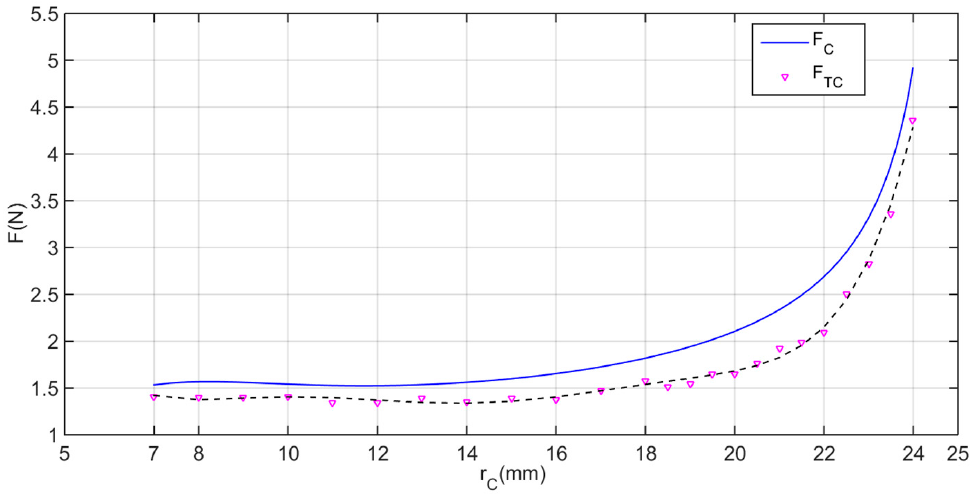
F compared with the theoretical values C